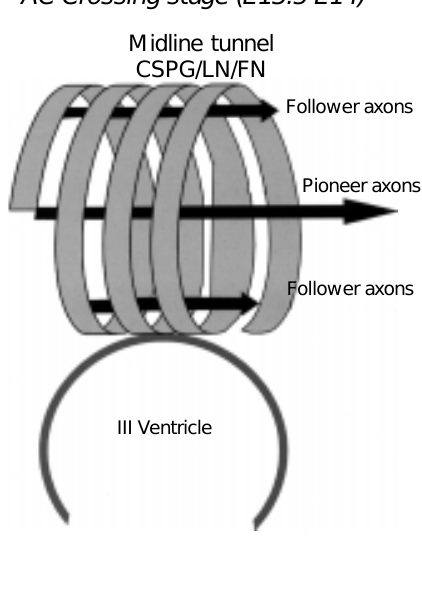
Figure 3 - Schematic representa- tion of the anterior commissure (AC) branching after crossing the midline region of the brain. Chondroitin sulfate (CS) and tenascin (TN) form boundaries for AC limbs that diverge in or- der to reach different rostro-cau- dal